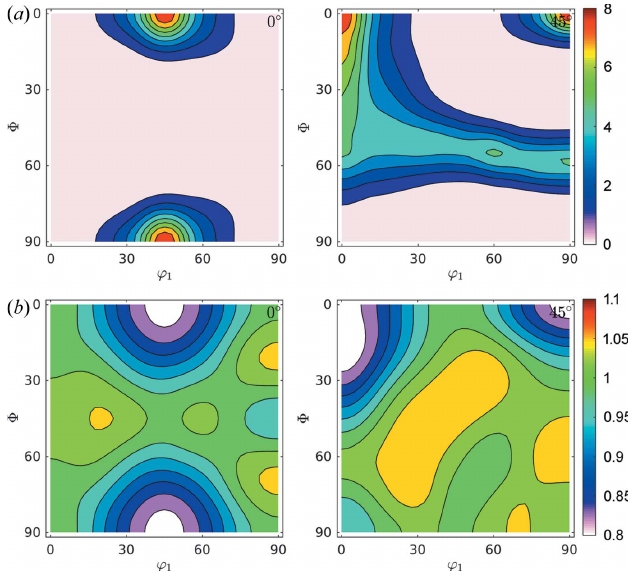
Figure 6 Sections at ’ 2 = 0 (cid:6) and ’ 2 = 45 (cid:6) for ( a ) ODFand ( b ) FWHM GDF for the IF cold-rolled sample. The increase of the FWHM in the orientations of the (cid:6) -fibre is in agreement with previous